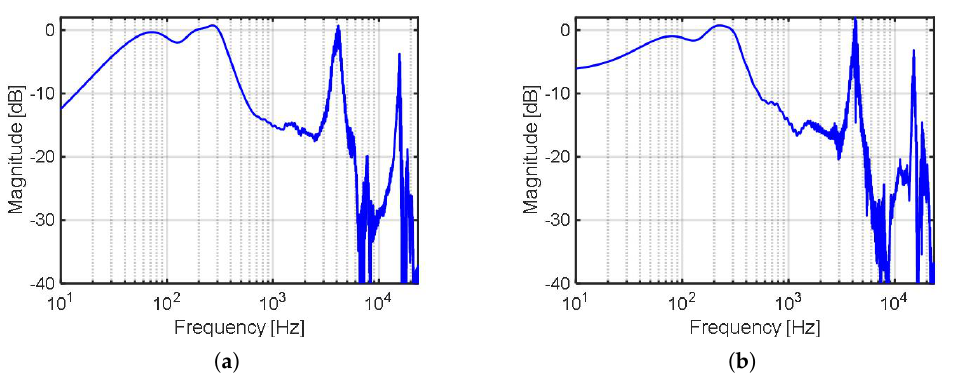
Figure 5. ( a ) Measurement of the primary path P ( z ) , ( b ) measurement of the acoustic secondary path S A ( z ) . Blue: Primary path, Red: Acoustic secondary path.